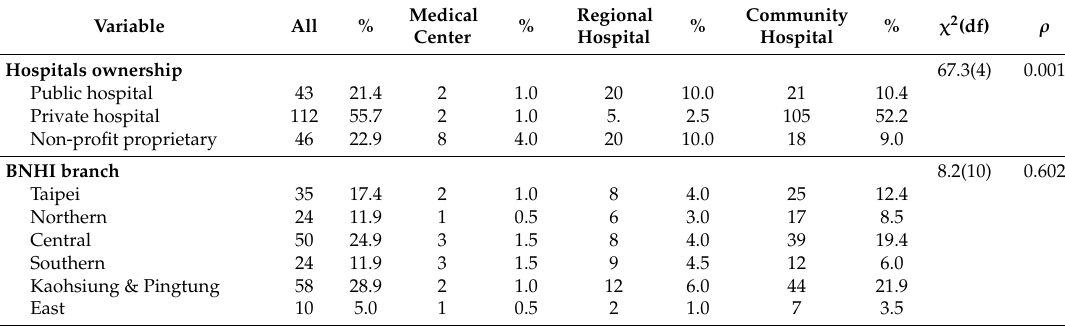
Table 3. Health service provider characteristics ( n =